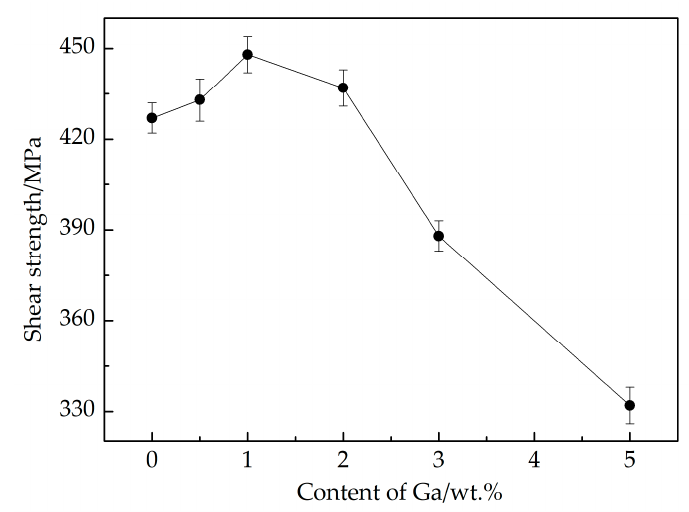
Figure 10. Shear strengths of the 304 stainless steel brazed joints.